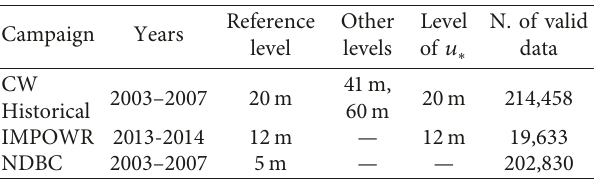
Table 1: Details about the two field campaigns conducted at the Cape Wind tower in Nantucket Sound and about the NDBC data set used in this